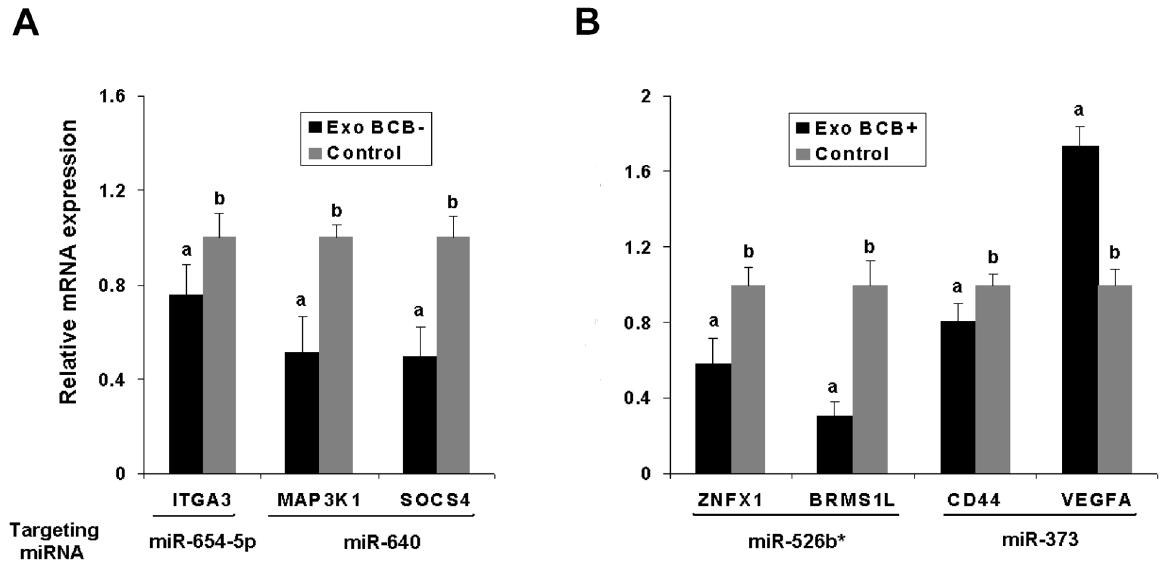
Figure 9. Changes in expression of target genes following exosomes transfection. Quantitative real-time PCR were carried out using gene- selective primers. miRNA target genes were selected using seed match and their involvement in important pathways. To elucidate the exosome mediated uptake of extra-cellular miRNAs can alter the abundance of target mRNAs we used the same exosome co-cultured granulosa cells which was used for miRNA abundance study. The histogram in this figure indicated that significantly lower expression of target mRNAs except VEGFA, suggesting possible involvement of transcriptional regulation of circulating miRNA. Different superscript letters (a,b) denote a significant difference between groups, such that groups not sharing a similar letter are significantly different from each other (P , 0.05). The data is presented as means 6 SD of three biological replicates.